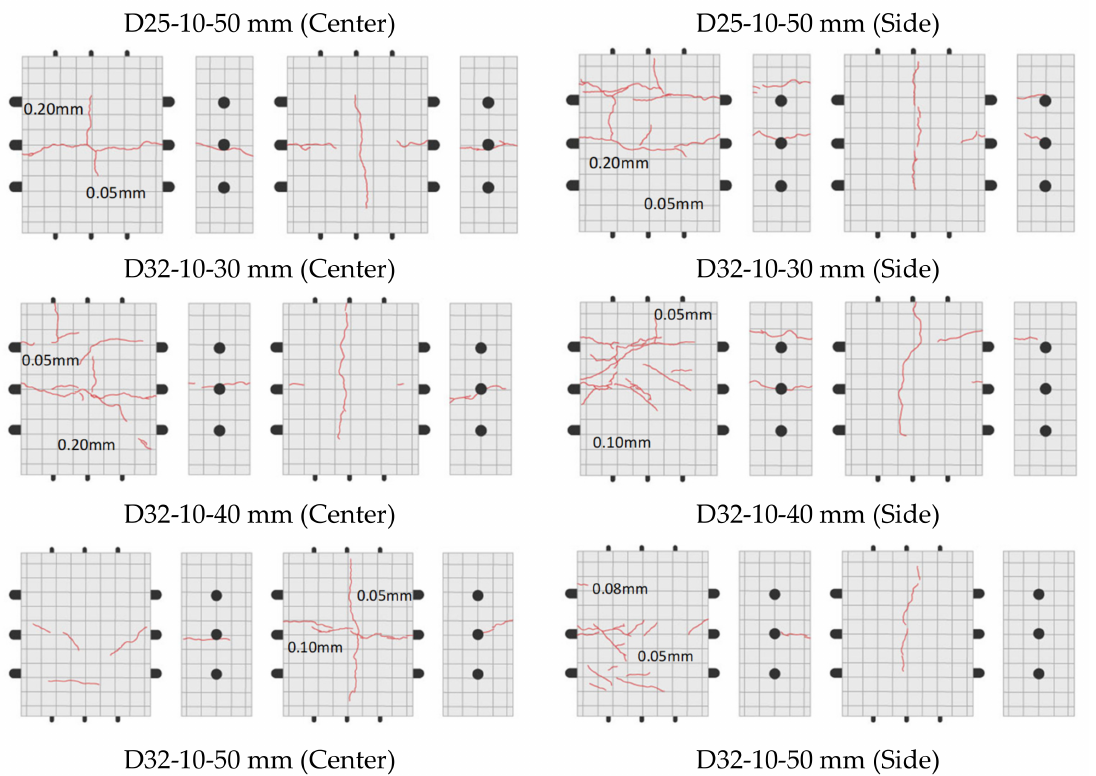
Figure 23. Crack characteristics of cross reinforced concrete by induction heating.